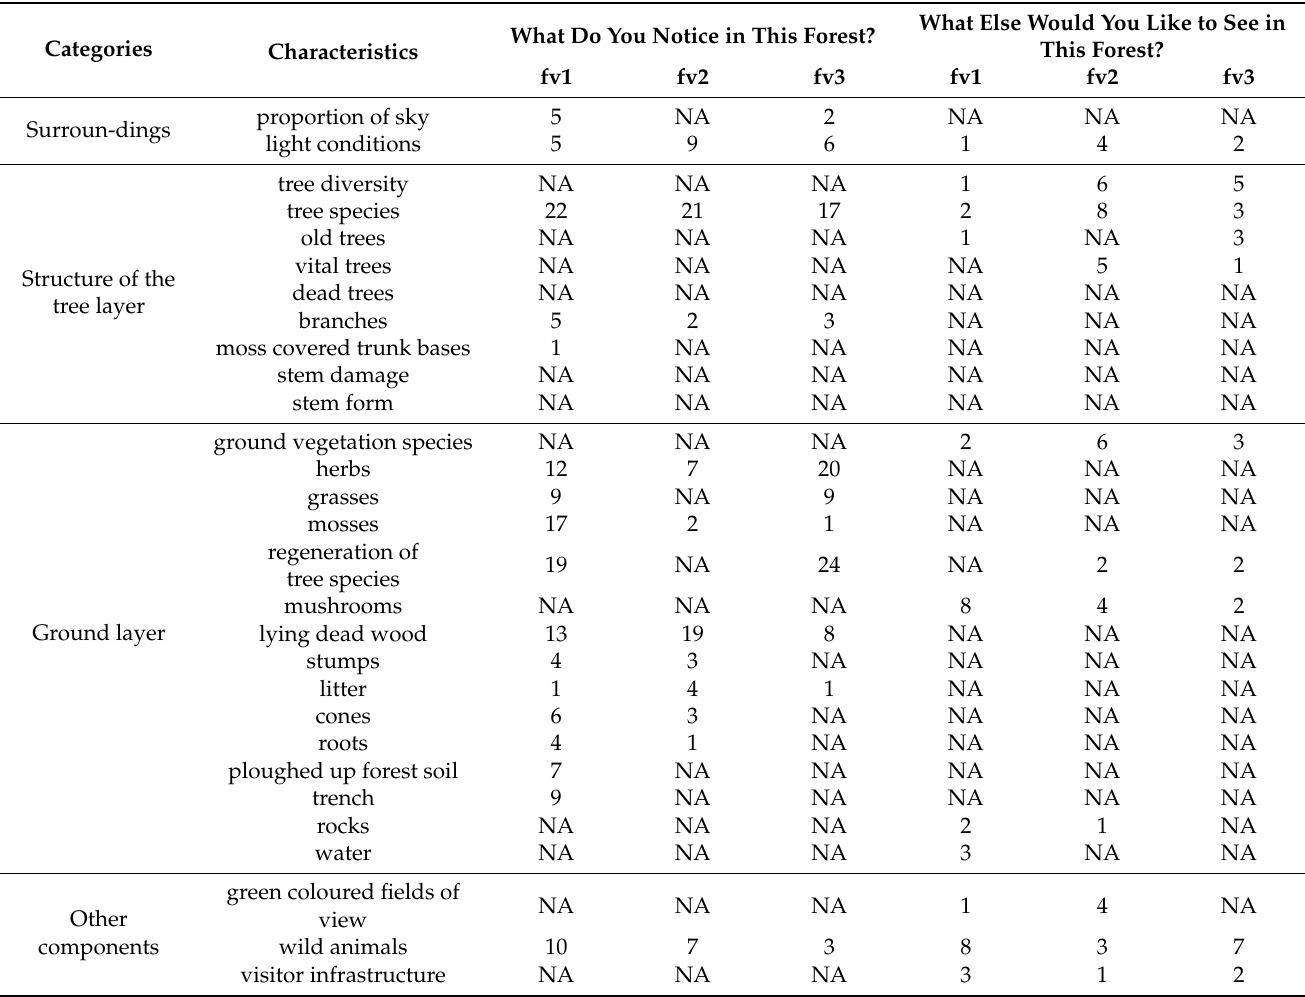
Table 7. The statements provided addressing the open questions of the survey: a) What do you notice in this forest? and b) What else would you like to see in this forest?—divided into the main characteristics: ‘surroundings’, ‘tree layer’, ‘ground layer’ and ‘other components’. (NA—no statement available, total number of participants, n =